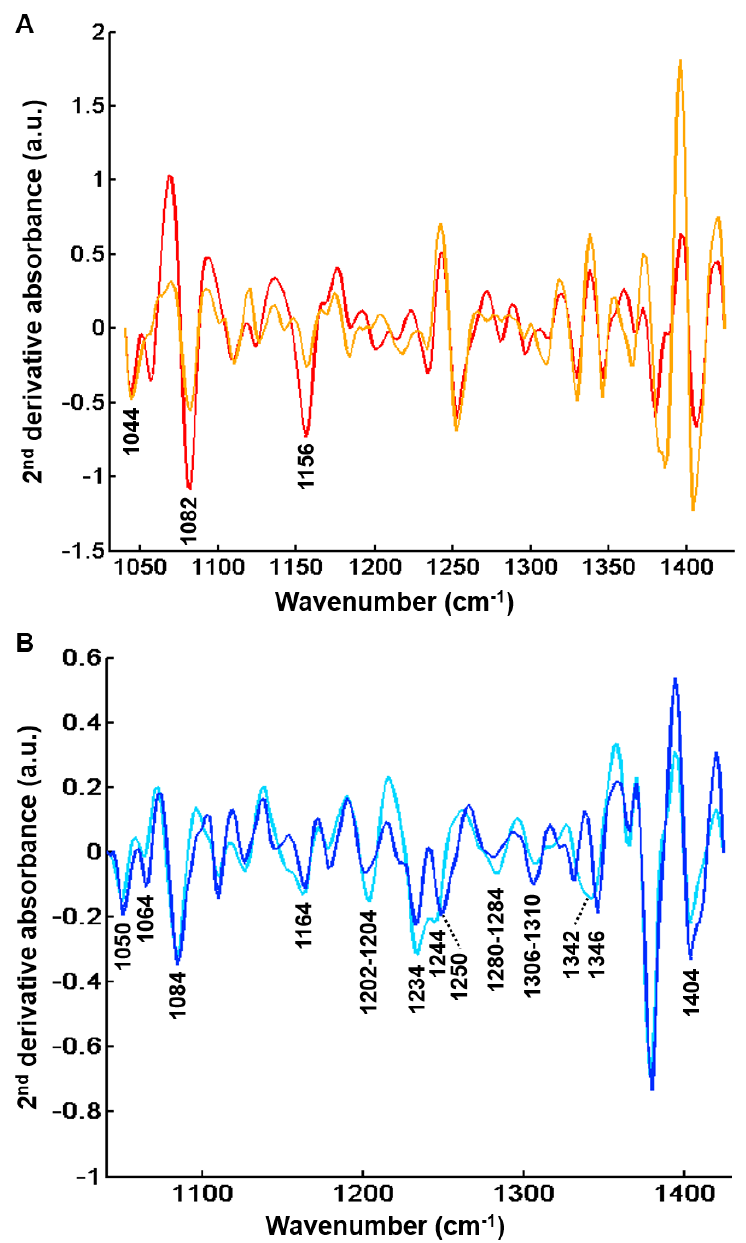
Figure 8. Second derivative centroid spectra after common k-means analysis (k = 4) of FTIR images from 48 hepatic samples without ( n = 25) and with ( n = 23) complications in the spectral range 1040–1425 cm − 1 . ( A ) Centroids corresponding to regeneration nodules. Peaks that can be tentatively assigned to glycogen are indicated ( B ) Centroids corresponding to fibrosis regions. Peaks that can be tentatively associated to collagen are indicated. Results are from FTIR images acquired with a projected pixel size of 2.7 μm.